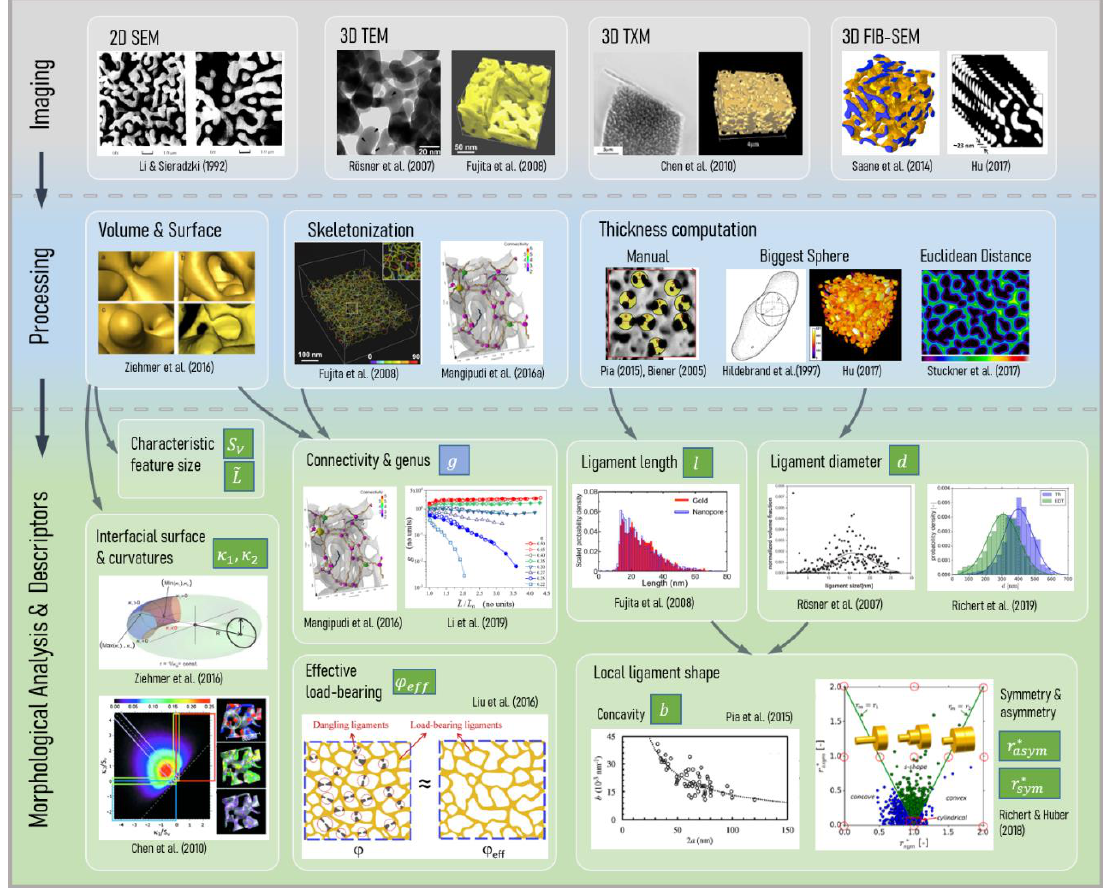
Figure 1. Overview of the morphological characterization divided into the three sequential stages of imaging, processing, and morphological analysis and descriptors. For figure reprint permissions, see Note at the end of the paper.